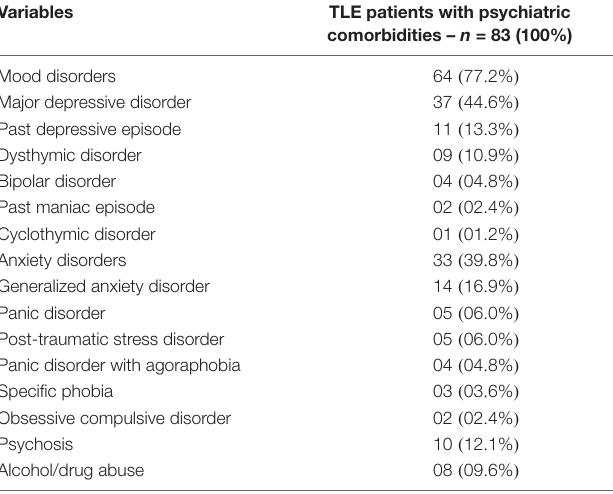
TABLE 2 | All psychiatric disorders in TLE